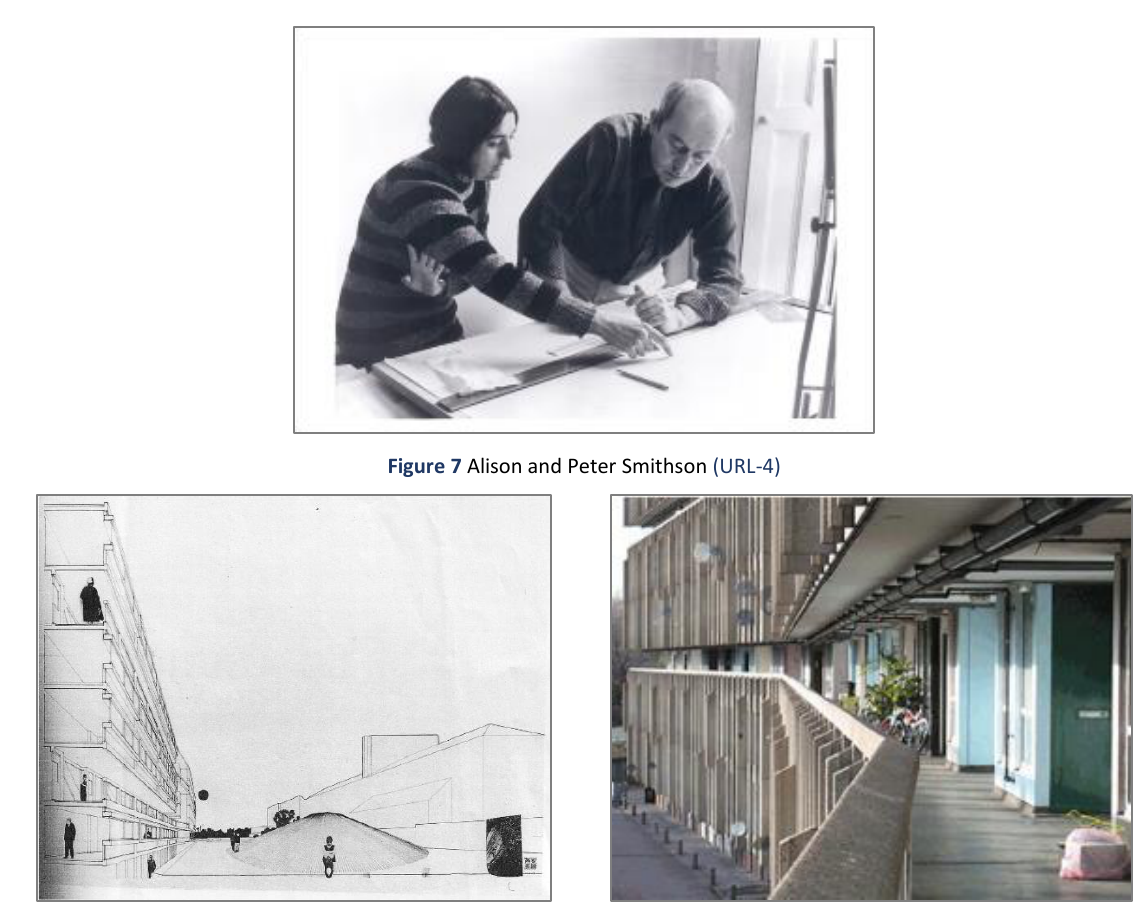
Figure 9 Robin Hood Gardens, Street in the Air